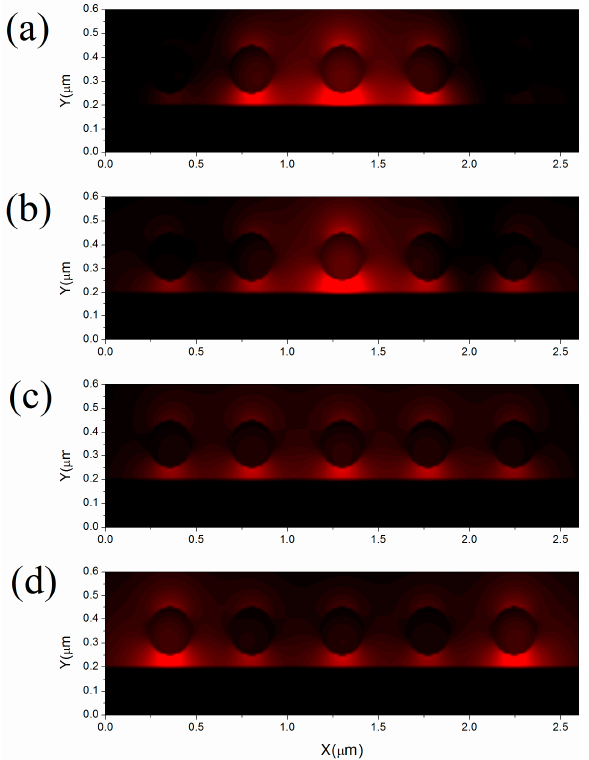
Figure 3. The cross section with different z coordinates. ( a ) z = 1.8 μ m; ( b ) z = 4.0 μ m; ( c ) z = 4.1 μ m; ( d ) z = 4.2 μ m.